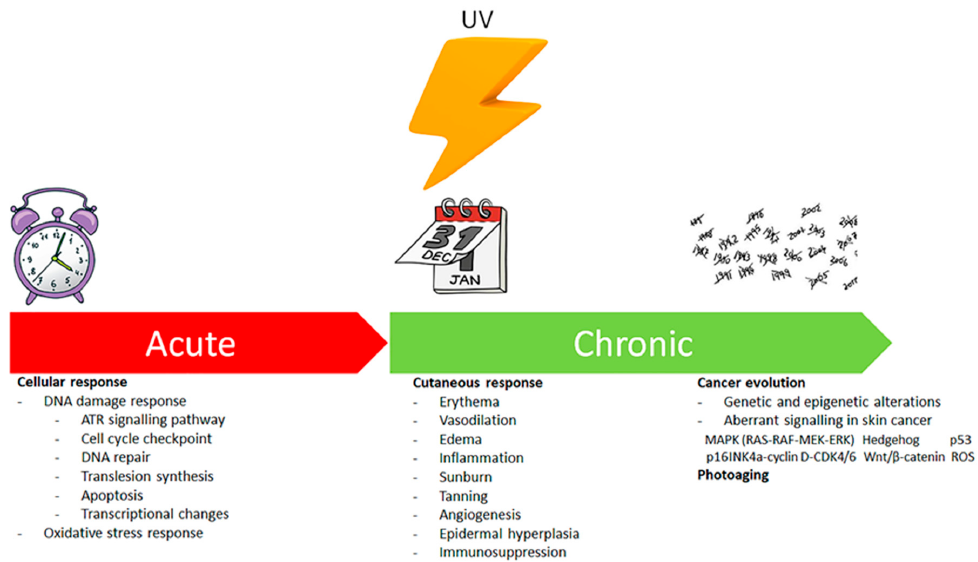
Figure 1. Acute and chronic e ff ects of ultraviolet (UV) radiation. Table 1. Lesions and biological responses associated with Ultraviolet (UV) radiation and photodynamic therapy (PDT) (in bold italics are the mechanisms enabling tumour challenging; in italics , those having both pro- and anti-tumorigenic e ff ects). Reactive oxygen species, ROS; extracellular matrix, ECM; malondialdehyde, MDA; thiobarbituric reactive substances, TBARS;